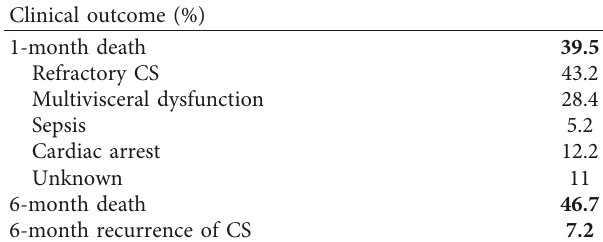
Table 4: Clinical outcome.